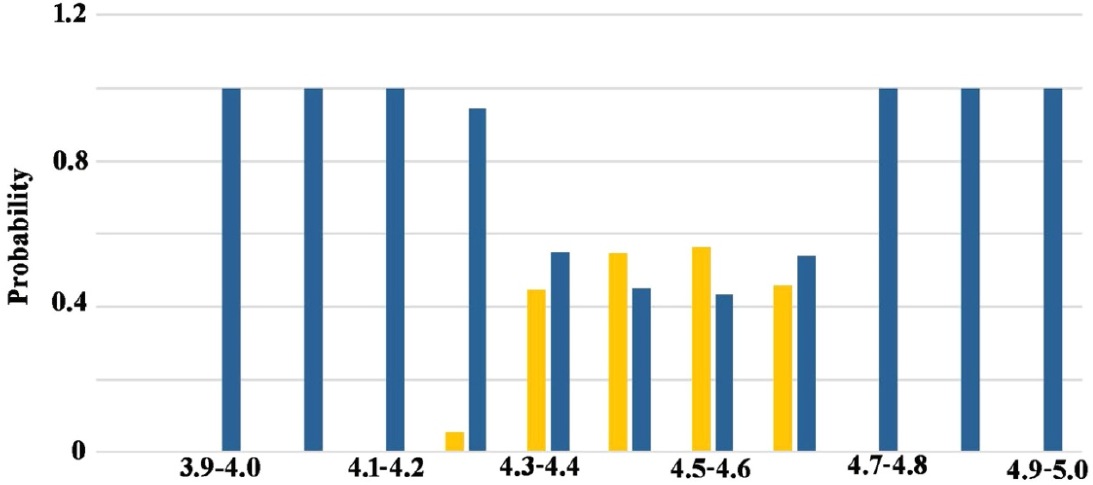
Figure 8. Probability for sand (yellow) or sandstone (blue) for a given range of mean frequenc y .